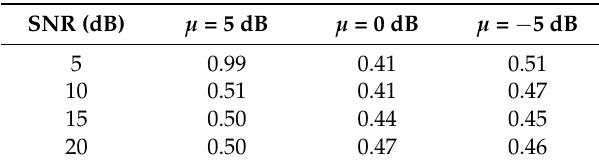
Figure 2. The effect of the power allocation parameter K on the OP performance. Table 1. OPA parameters K .